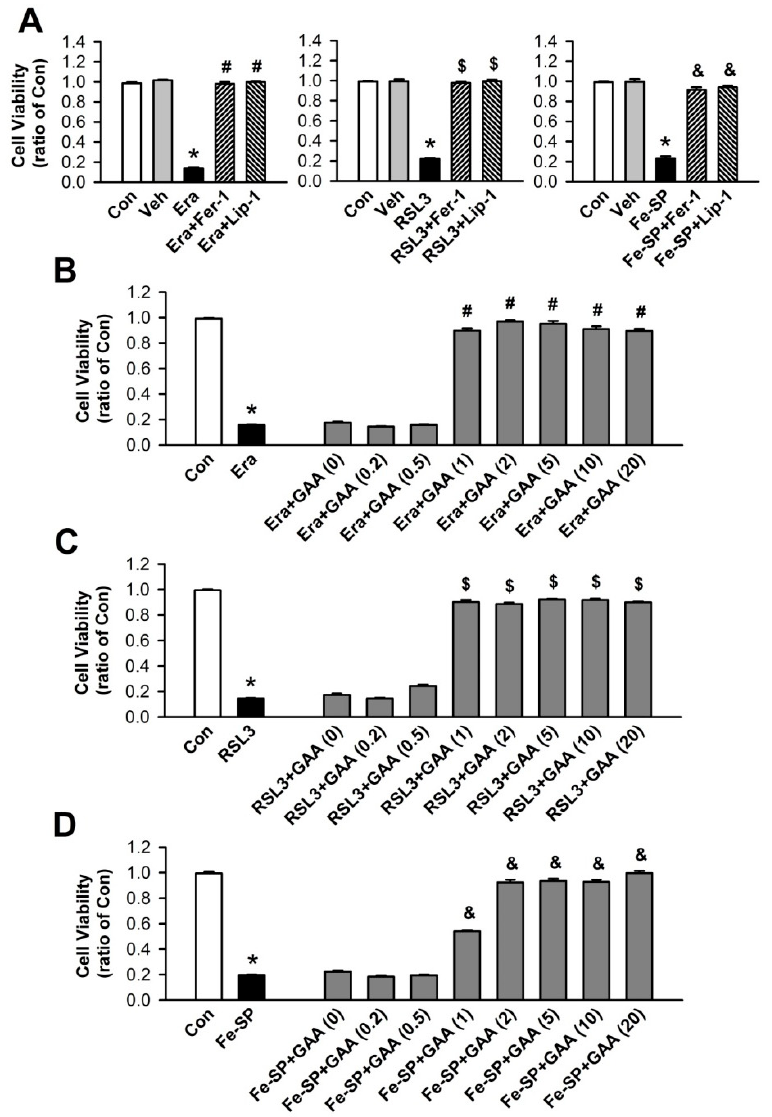
Figure 1. GAA prevents ferroptotic cell death in H9c2 cardiomyoblast cells. ( A ) MTT results showing a significant decrease in cell viability at 16-h postexposure to 1- µ M Era (left panel), 0.1- µ M RSL3 (central panel), and 0.5- µ M Fe-SP (right panel); these effects were rescued by 1- µ M Fer-1 and 2- µ M Lip-1 (n = 12). GAA (1–20 µ M) treatment abolished ( B ) Era-, ( C ) RSK3-, and ( D ) Fe-SP-induced cell viability inhibition (n = 12). In each group, 3 samples were analyzed, and the same experiment was assessed by repeating cell culture four times. All data represent means ± SEM. * p < 0.05 versus the control group; # p < 0.05 versus the Era; $ p < 0.05 versus RSL3; & p < 0.05 versus Fe-SP. Con, control; Veh, vehicle; Era, erastin; Fer-1, ferrostatin-1; Lip-1, liproxstatin-1; RSL3, (1S,3R)-RSL3; Fe-SP, chlorido [N, N-disalicylidene-1,2-phenylenediamine] iron (III); GAA, gossypol acetic acid. Ferroptosis is a form of regulated cell death that is dependent on intracellular iron and ROS accumulation; it is characterized by lipid peroxidation. To test whether GAA (2 μ M) could inhibit Era-, RSL3-, and Fe-SP-induced lipid peroxidation in H9c2 cells, a TBARS assay was used to detect the level of MDA in lysates. At 16 h after ferroptosis inducers and GAA cotreatments in H9c2 cells, GAA was found to attenuate Era-, RSL3-, and Fe-SP-induced an increase in lipid peroxidation in these cells (Figure 2A). To verify GAA inhibition of ferroptosis, we detected the mRNA levels of Ptgs2 , a molecular marker of ferroptosis, via real-time PCR. Notably, GAA reduced Era-, RSL3-, and Fe-SP-induced